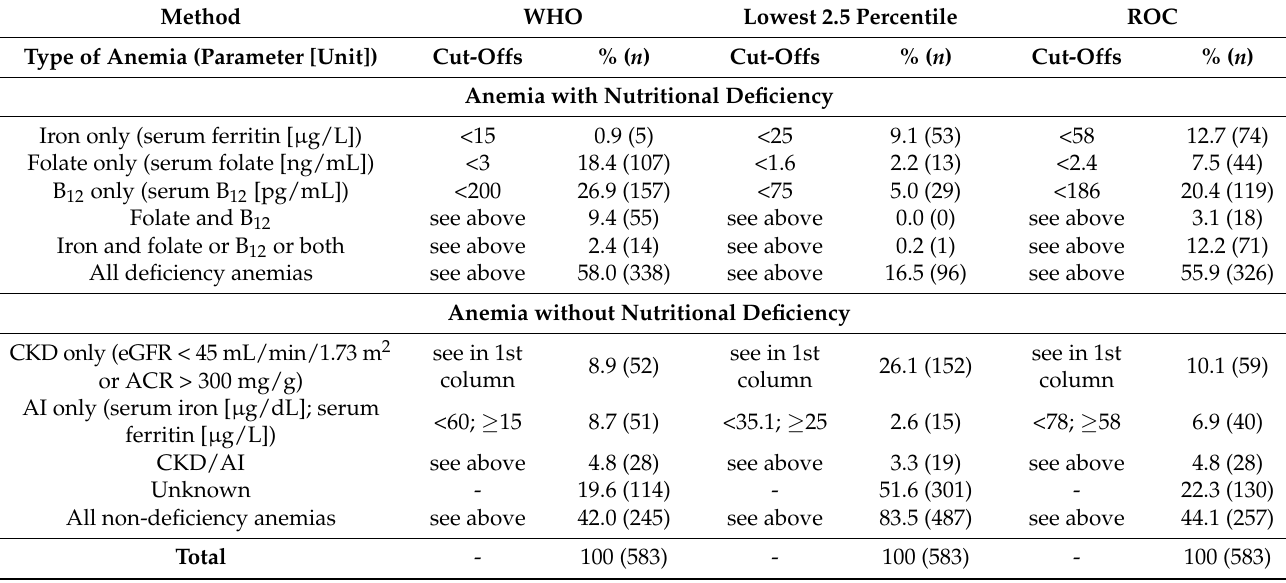
Table 2. Etiologic classification of anemias in the PolSenior study with cut-offs established according to different methods. Method WHO Lowest 2.5 Percentile